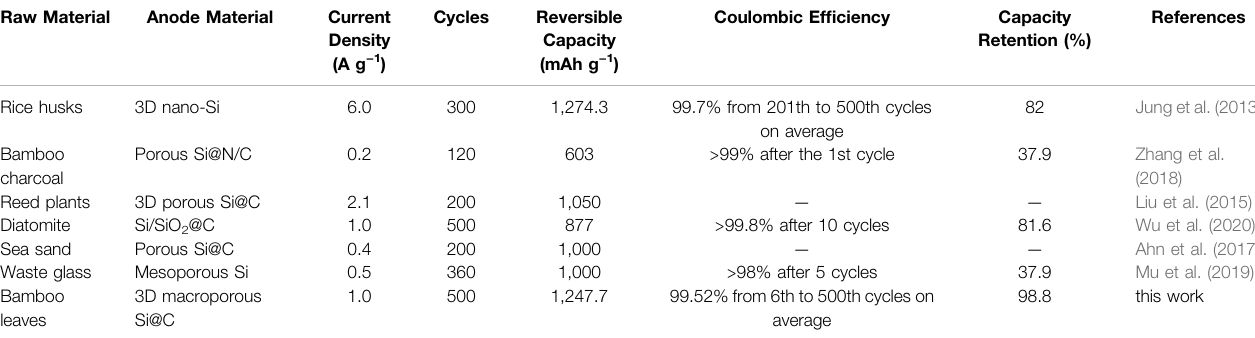
TABLE1 | Comparison of electrochemical performance with other Si-based anodes fabricated via magnesiothermic reduction. Raw